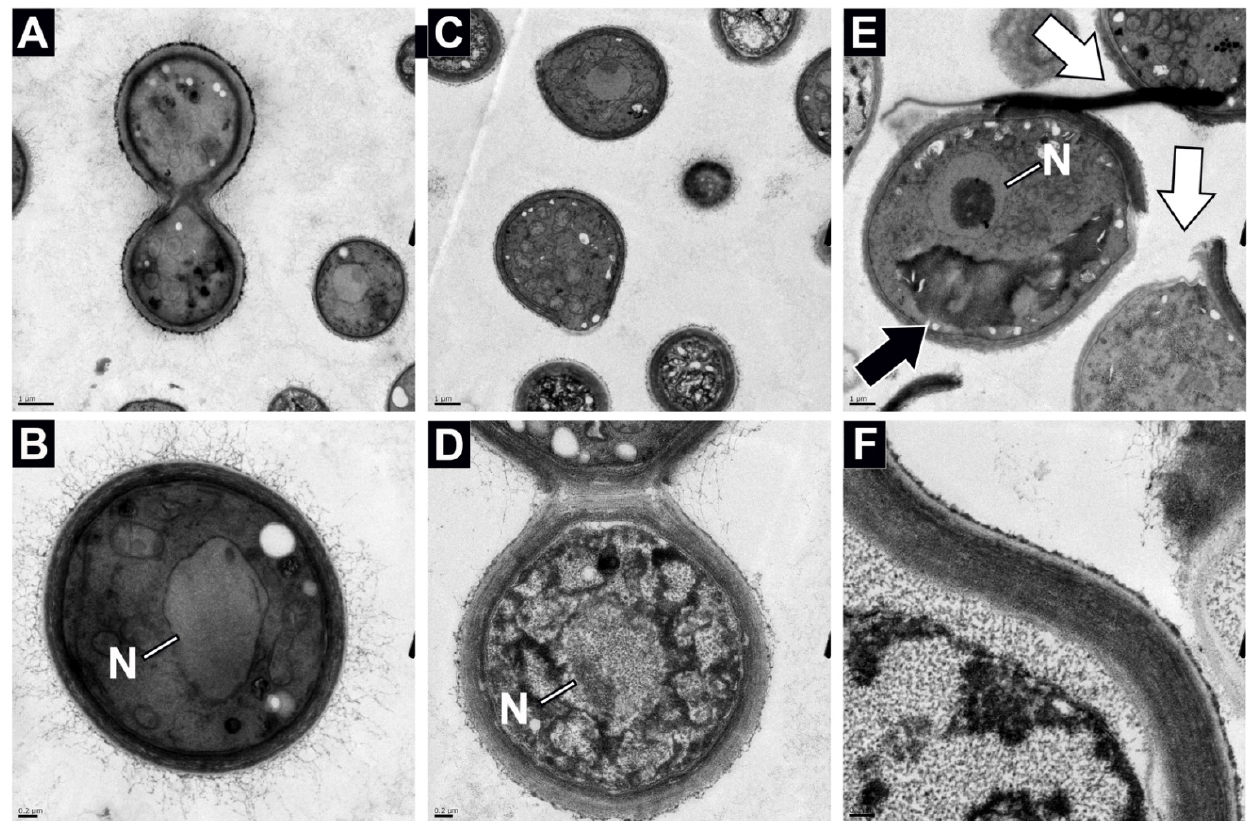
Figure 4. Analyses of transmission electron microscope (TEM) micrographs of SD ( A , B ), CO ( C , D ), and µG ( E , F ) grown N. tulchinskyi cells demonstrated differences in cell size, cell wall thickness, and internal organelle structures. SD and CO demonstrate similar size cells and similar intracellular morphology, while µG grown cells appear to have a different internal organizational structure of organelles. At higher magnifications (lower panels), the cell wall thickness can be seen to be thicker for µG grown cells than for SD or CO grown cells. The cells also appear to be having lower abundance of fine scale fimbriae on the surface of µG cells, as compared to SD and CO grown cells. Along with their large size, the µG grown cells are distinguished by the shedding and peeling bud scars from their surfaces, denoted by white arrows ( C ). Additionally, µG grown cells have the presence of large unknown organelles/structures, as denoted by the black arrow. Representative TEM micrographs are given. The scale bar for ( A , C , E ) is 1 µm, and the scale bare for ( B , D , F ) is 0.2 µm.